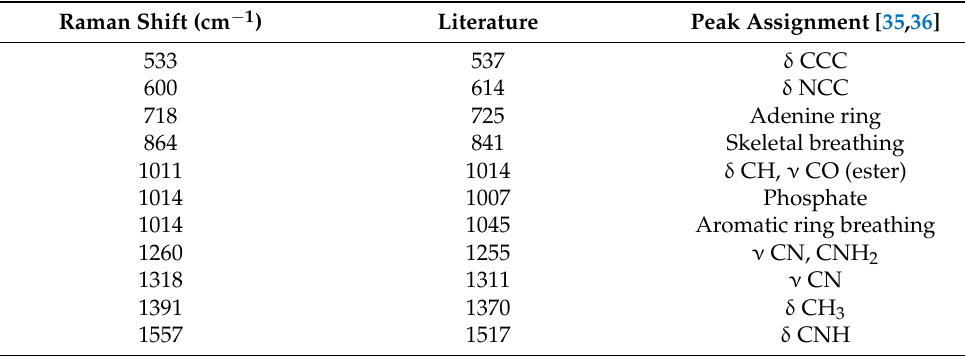
Table 2. Summary of SERS shifts of tenofovir using Au/dextran nanoparticles. Raman Shift (cm − 1 ) Literature Peak Assignment